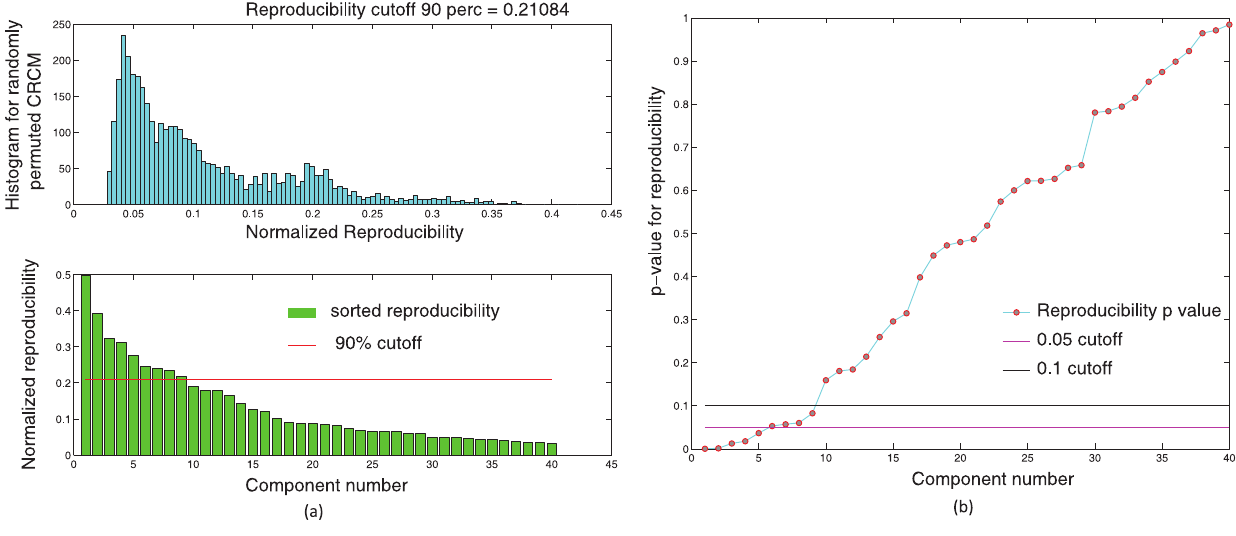
Figure 8. Single subject rsfMRI ICA runs across 23 subjects were combined using a RAICAR-N analysis. Figure (a) shows the observed values of normalized reproducibility (bottom) as well as the ‘‘null’’ distribution of normalized reproducibility across R ~ 100 simulations (top). Figure (b) shows the p -values for each IC along with the 0 : 05 and 0 : 1 cutoff lines.